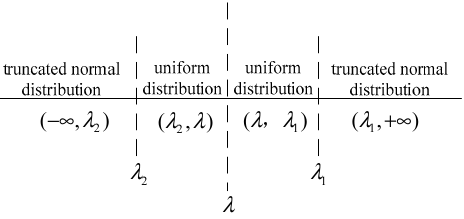
Figure 3. The distribution of the reconstructed data.